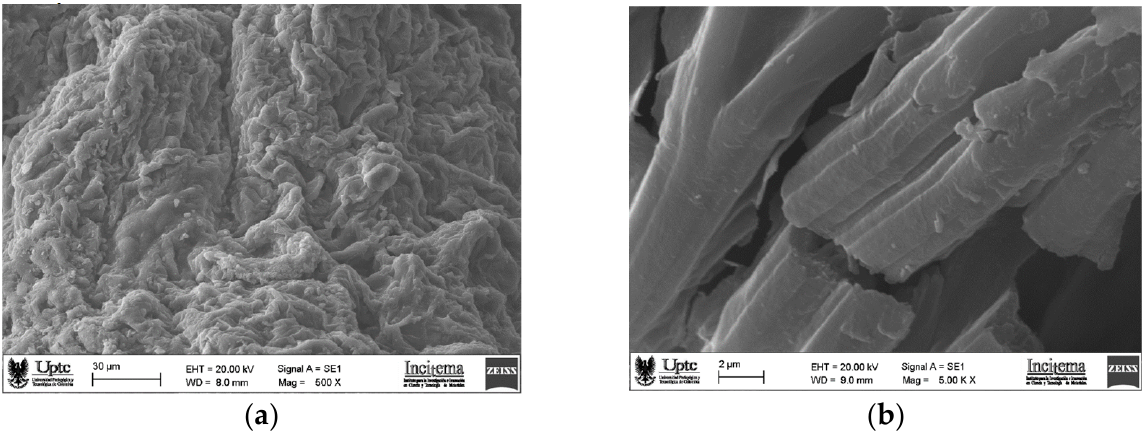
Figure 5. SEM micrograph images of the surface at 500 × ( a ) and 5000 × ( b ) of powder mucilage from yellow pitahaya fruit peel.